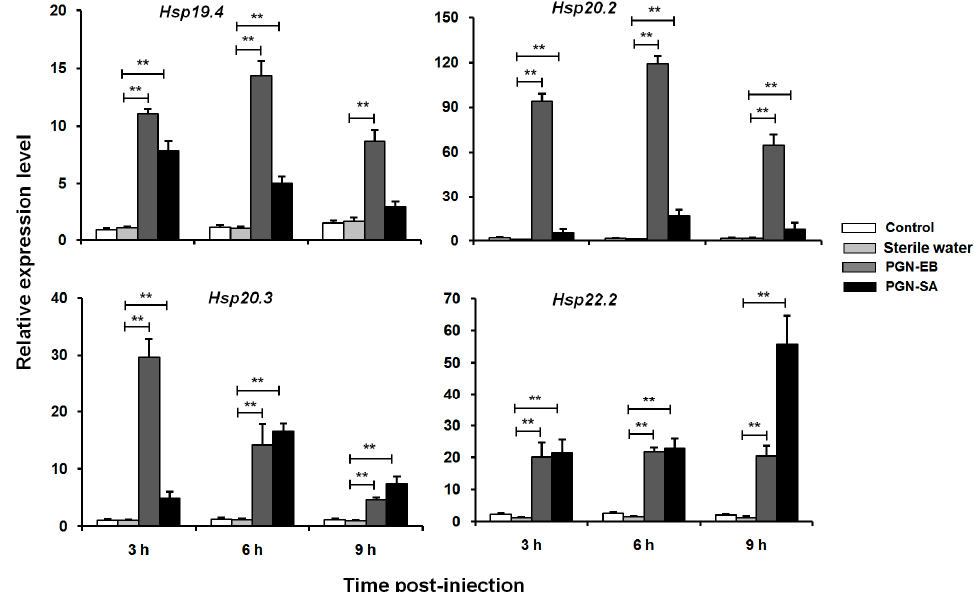
Figure 7. Relative expression levels of four LsHsp genes in L. serricorne after PGN-EB and PGN-SA challenges. Control: pricked with the micro-injection needle without injection; Sterile Water: injected with 200 nL sterile endotoxin-free water; PGN-SA: injected with 200 nL peptidoglycan from Staphylococcus aureus (PNA-SA) solution; PGN-EB: injected with 200 nL peptidoglycan from Escherichia coli 0111:B4 (PNA-EB) solution. Significant differences were determined using a t test and indicated by * ( p < 0.05) or ** ( p < 0.01).